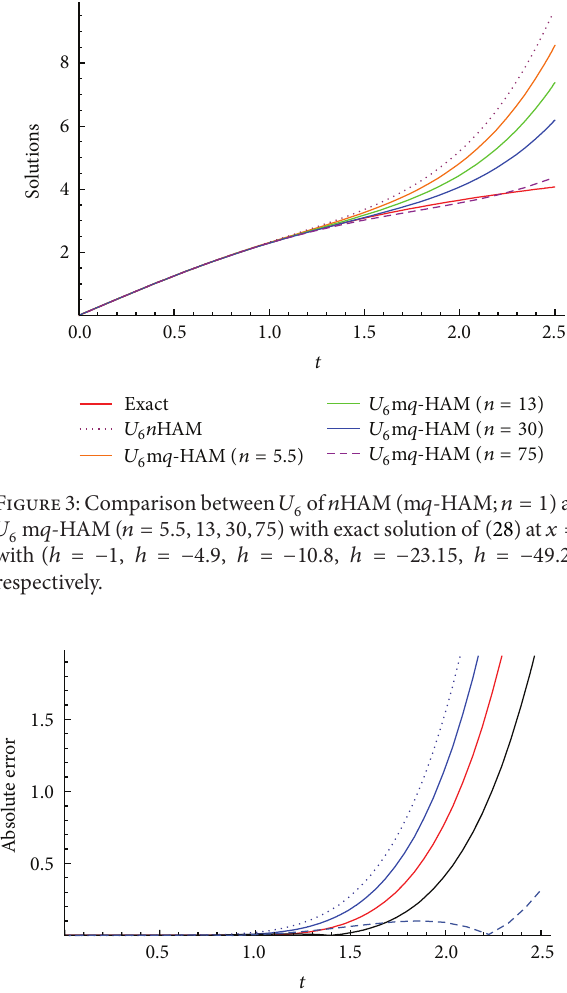
Figure 2: ℎ -curve for the (m 𝑞 -HAM; 𝑛 = 13) approximation solution 𝑈 6 (𝑥,𝑡; 13) of problem (28) at different values of 𝑥 and 𝑡 .